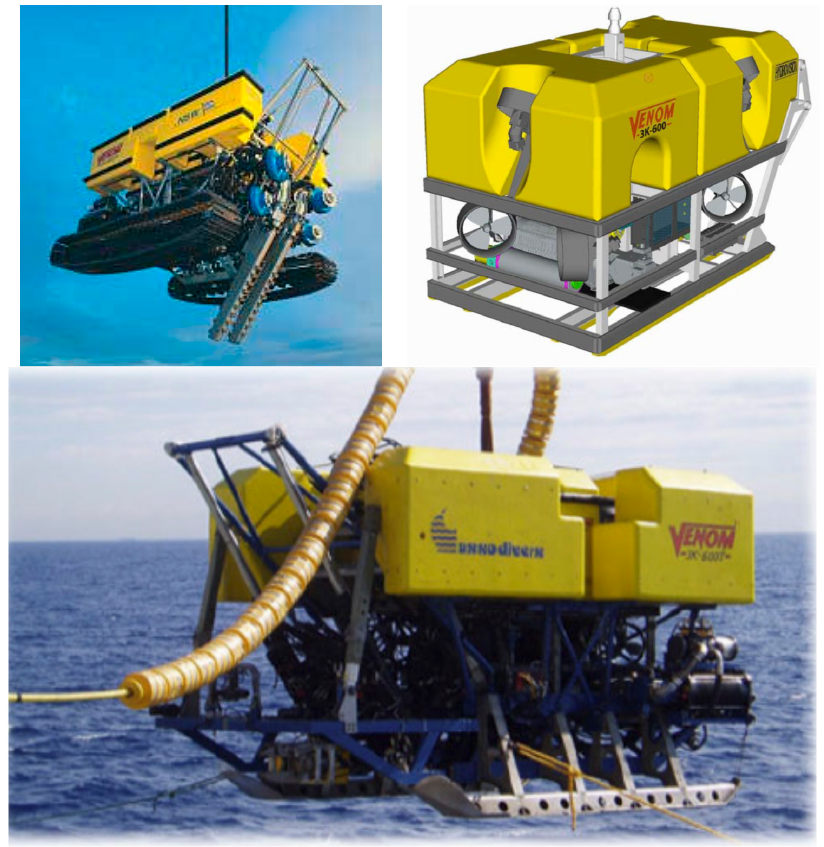
Figure 15. Some photos of the real jetting ROV used in the Lâpseki–Sütlüce installation.